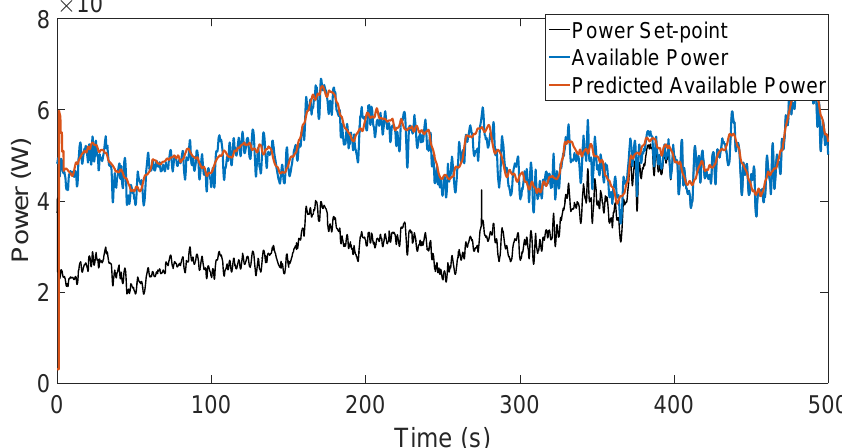
Figure 10. Set-point and available power for the tested wind farm.